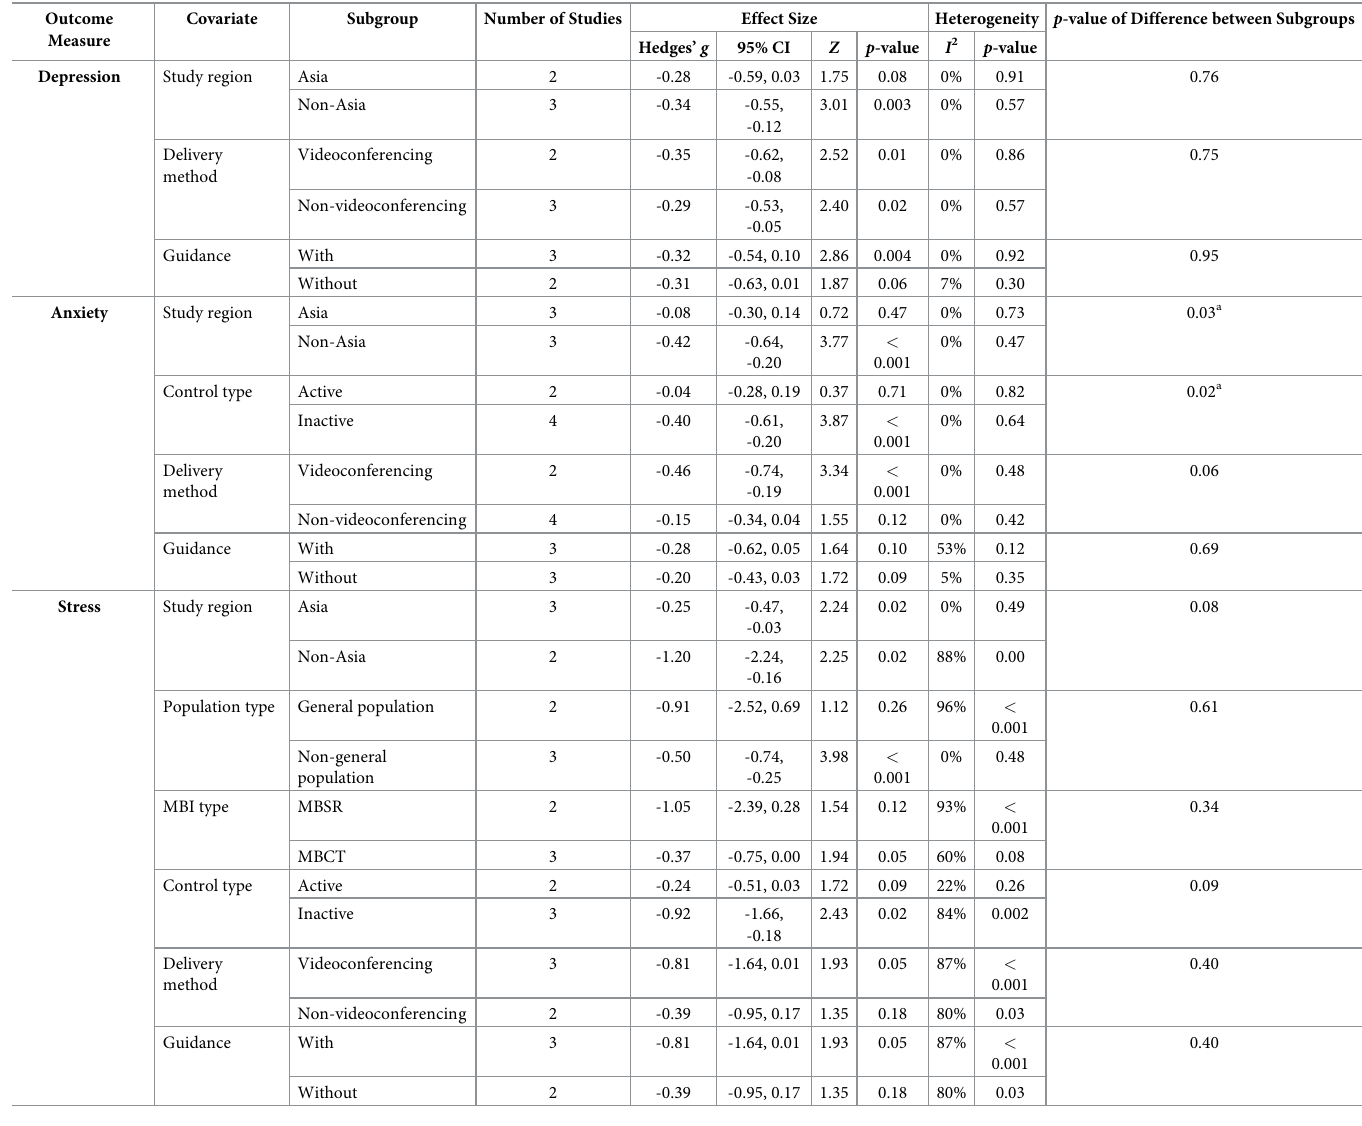
Table 2. Summary of subgroup analyses of online MBIs effect on mental health outcomes at post-intervention (including outliers). Outcome Measure